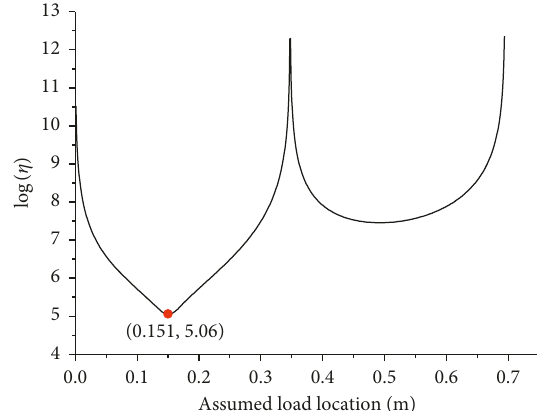
Figure 16: The optimization function value of impact A.